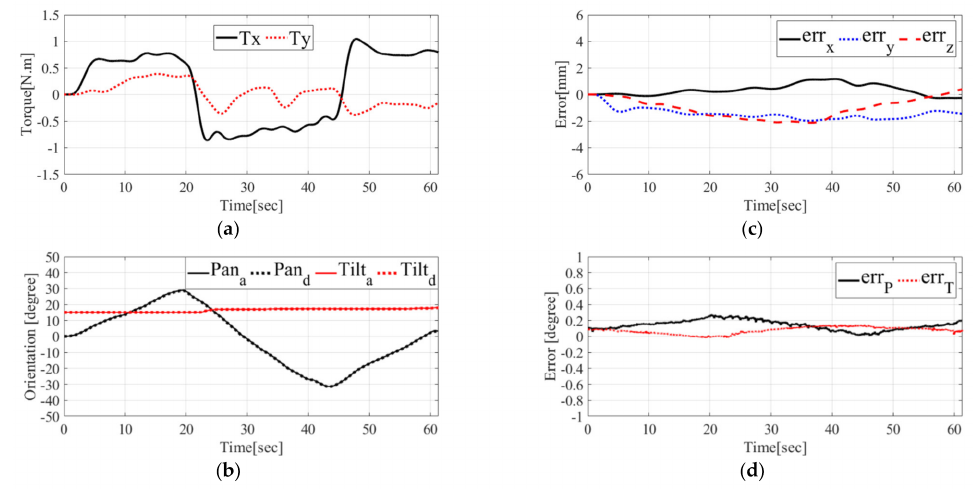
Figure 8. Experimental results in pan motion: ( a ) measured torque; ( b ) trajectory of desired and actual orientation; ( c ) position error of remote center; ( d ) orientation error of